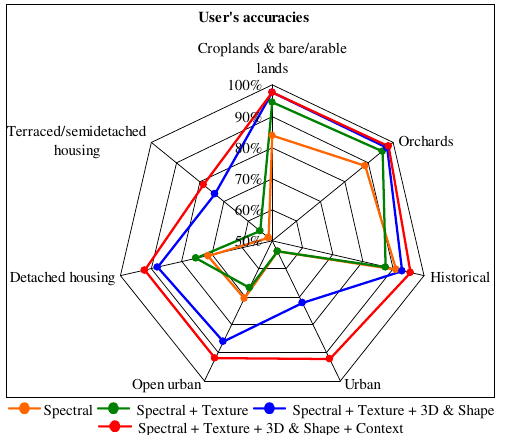
Figure 3. User’s accuracies as feature groups are combined.